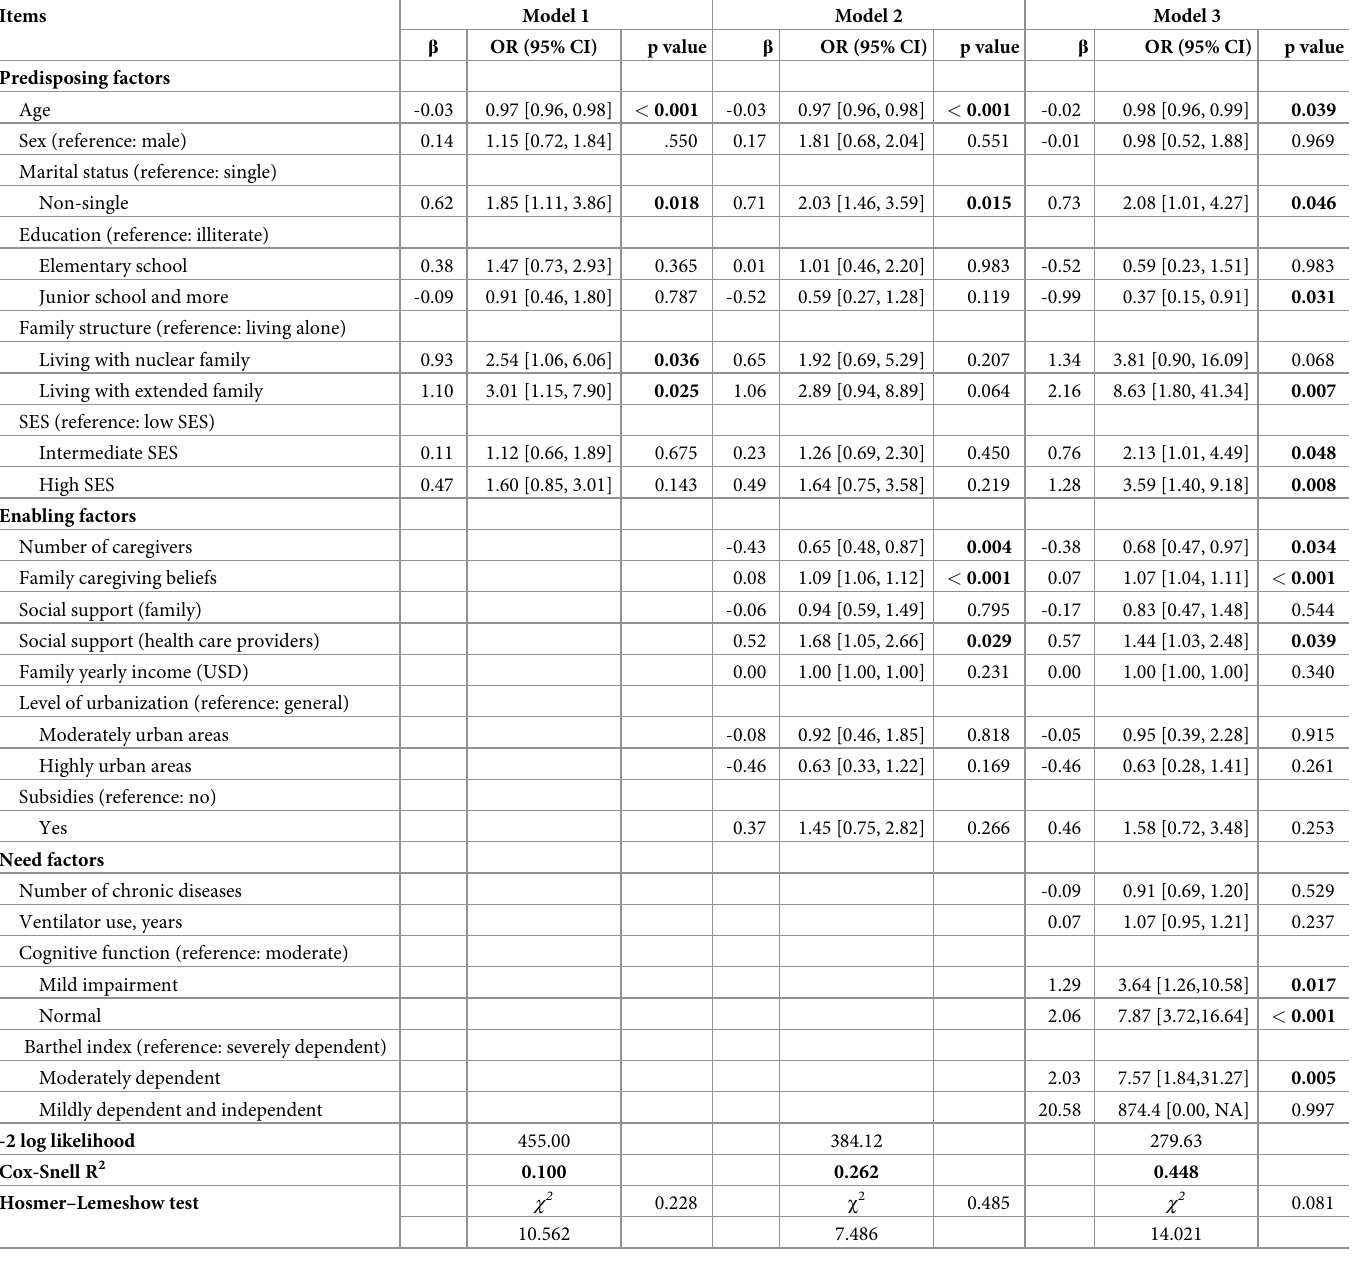
Table 2. Hierarchical logistic regressions of utilization among patients with long-term ventilator